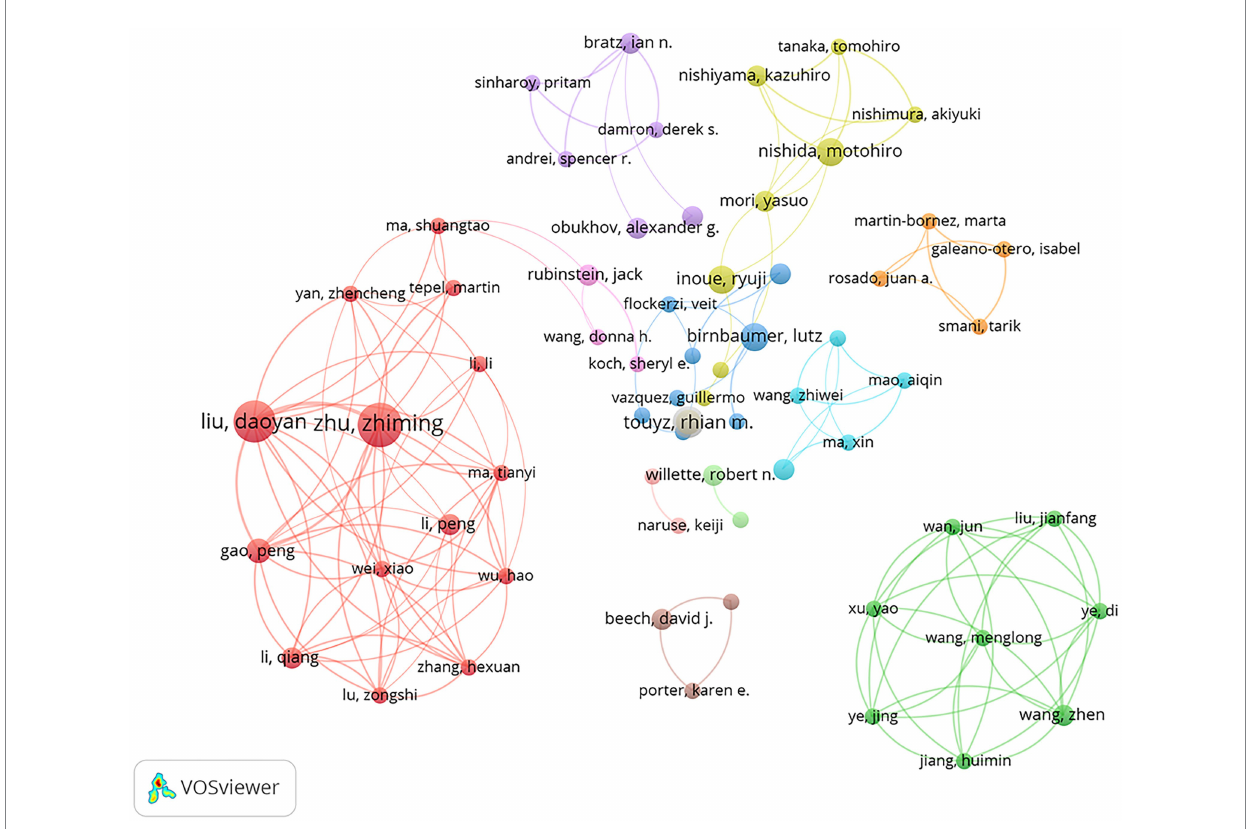
FIGURE 6 The co-authorship analysis depicts the 77 institutions grouped into 19